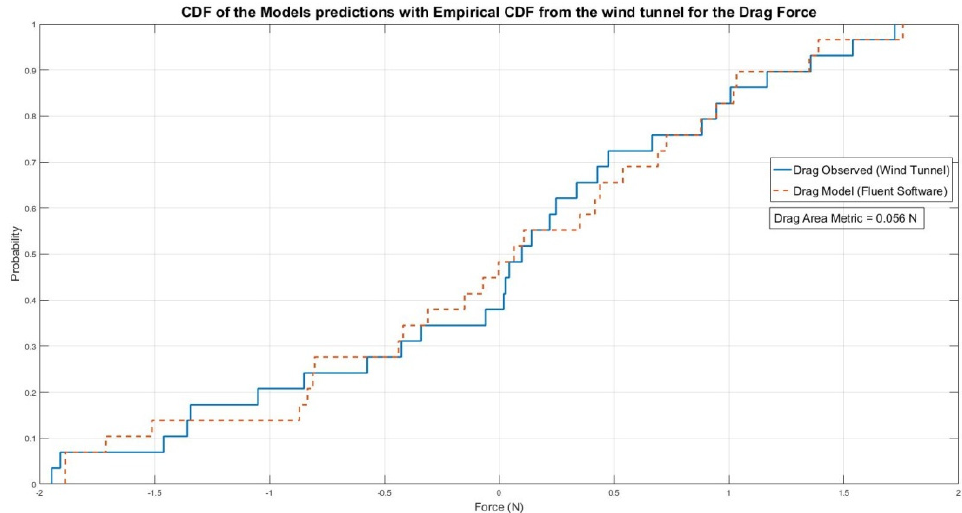
Figure 25. Area metric results for drag forces.